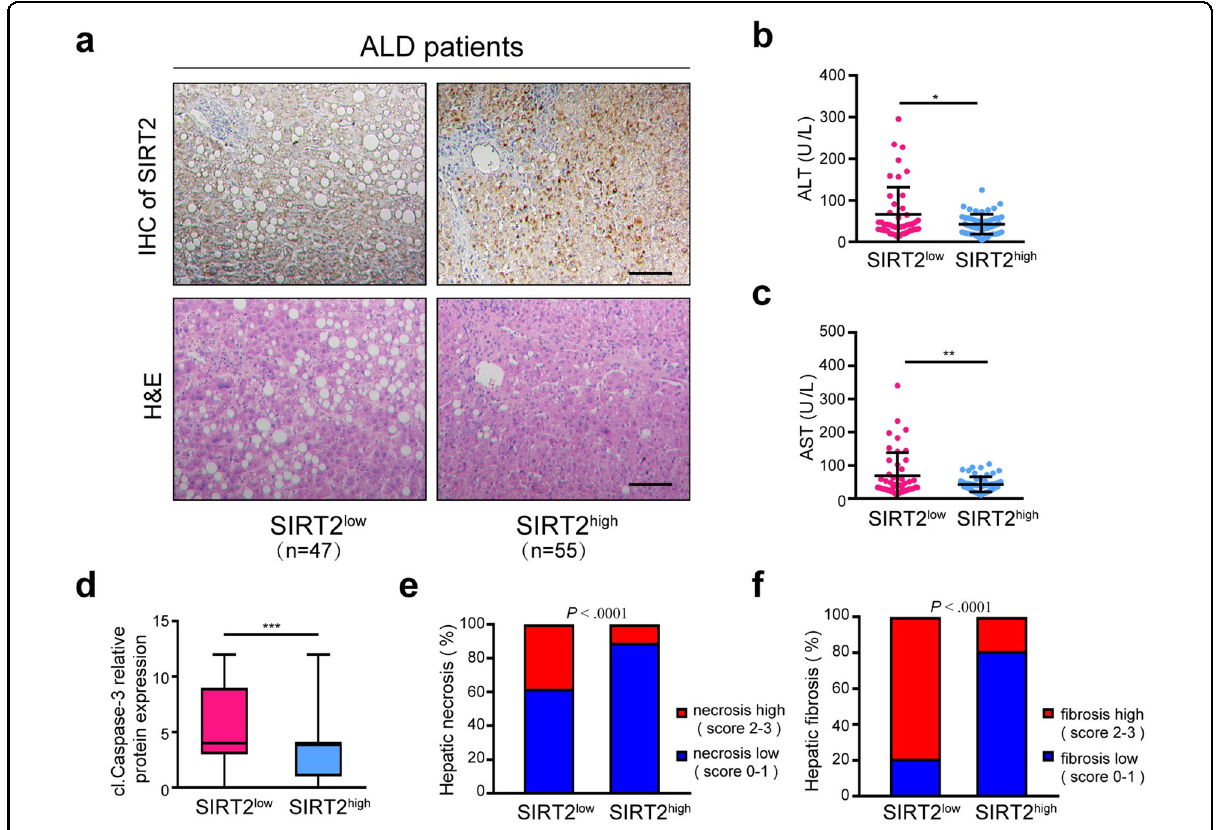
Fig. 1 SIRT2 protein level negatively correlates with the severity of ALD in patients. a Representative IHC images of liver tissues from ALD patients for the lower (SIRT2 low , IRS ≤ 5, n = 47) and higher (SIRT2 high , IRS > 5, n = 55) expressions of SIRT2. The scale bar represents 50 μ m. b – f Plots of serum ALT ( b ) and AST ( c ), cl.Caspase-3 IRS scores ( d ), and the percentages of liver tissues with high and low necrosis ( e ) or fi brosis ( f ) in SIRT2 low and SIRT2 high groups. Statistical signi fi cance was determined by two-tailed Student ’ s t- test ( b – d ), Pearson ’ s χ 2 test ( e , f ). Data are shown as means ± SD and were considered statistically signi fi cant at * P < 0.05, ** P < 0.01, and *** P <